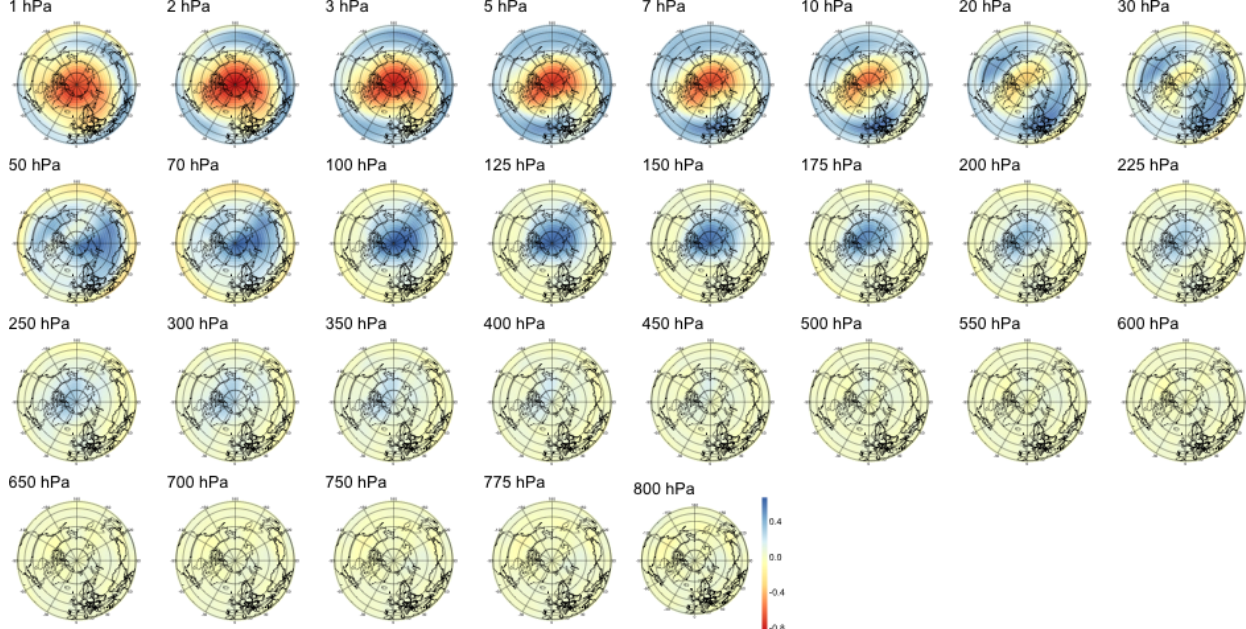
Figure B2. Pattern of PV anomalies maximizing correlation with the SSW index at a lead time of 14d.